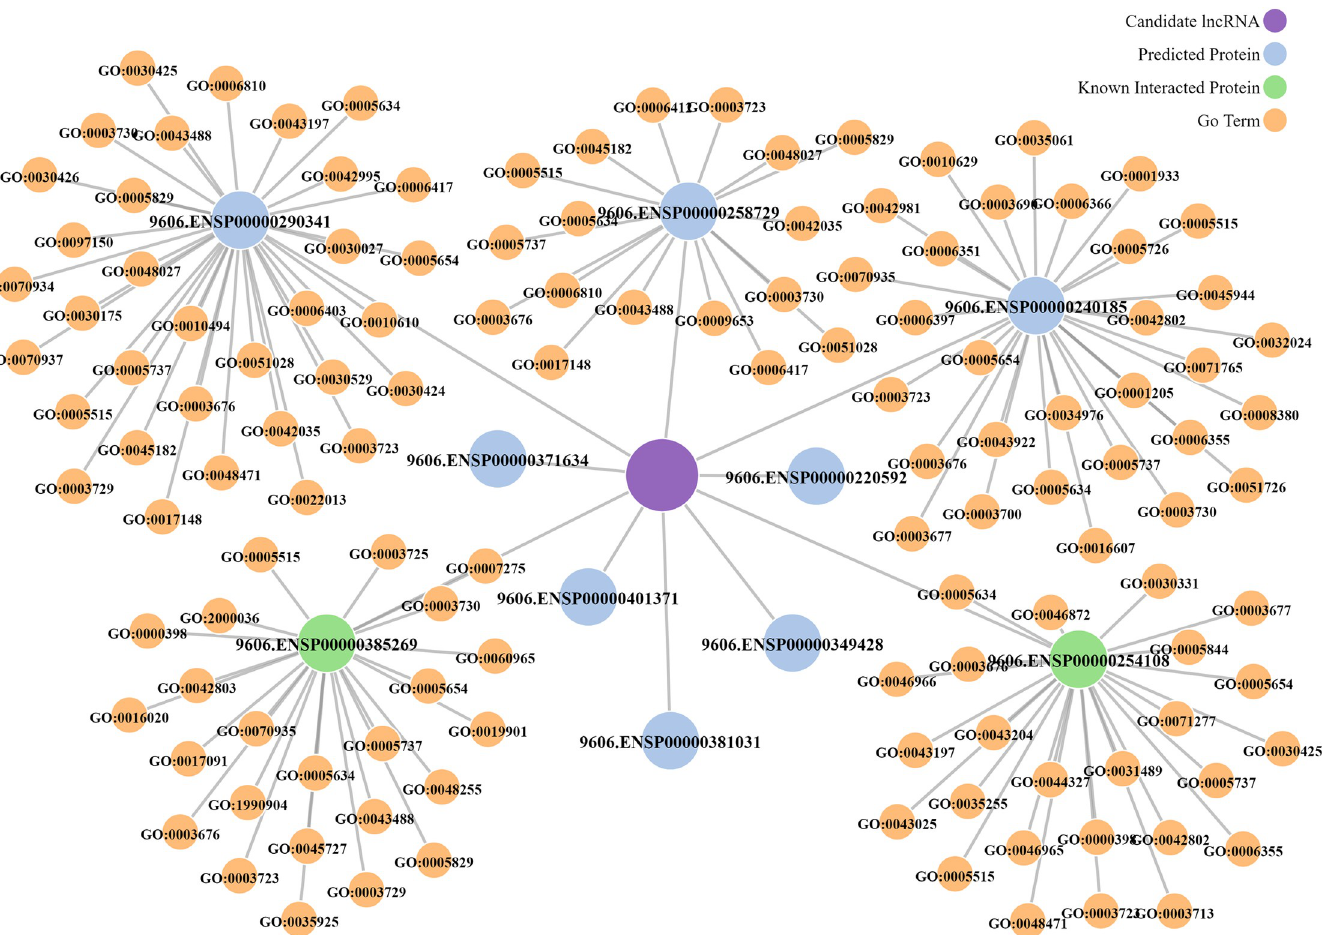
Fig 7. Visualization of top 10 predicted interacting proteins for the lncRNA: “NONHSAT041930”. Purple node stands for the lncRNA. Navy blue nodes indicate the predicted interacting proteins, and green nodes represent proteins that have observed interactions with the lncRNA. Moreover, we map the corresponding GO Terms (Orange nodes) of each interacting protein from QuickGO database (https://www.ebi.ac.uk/QuickGO/).